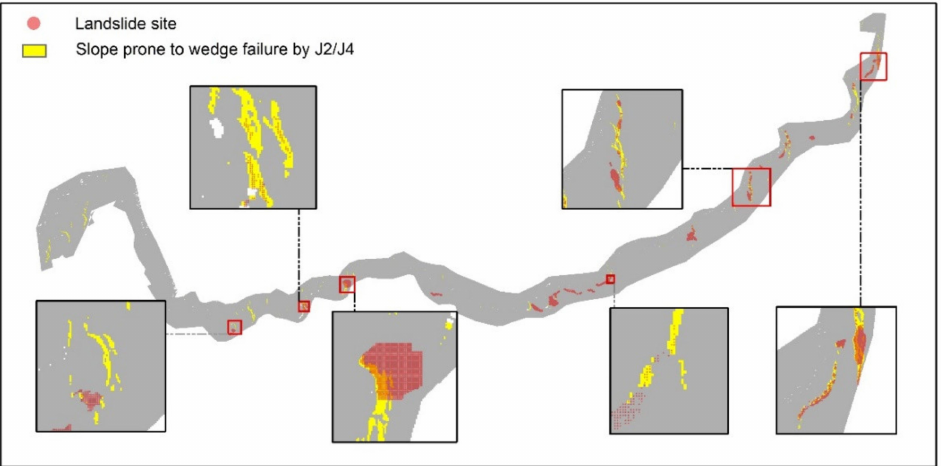
Figure 10. The comparison of locations of landslide sites of slope prone to wedge failures caused by J2/J4, highlighting the coincidence of the results of the kinematic analysis with real landslide